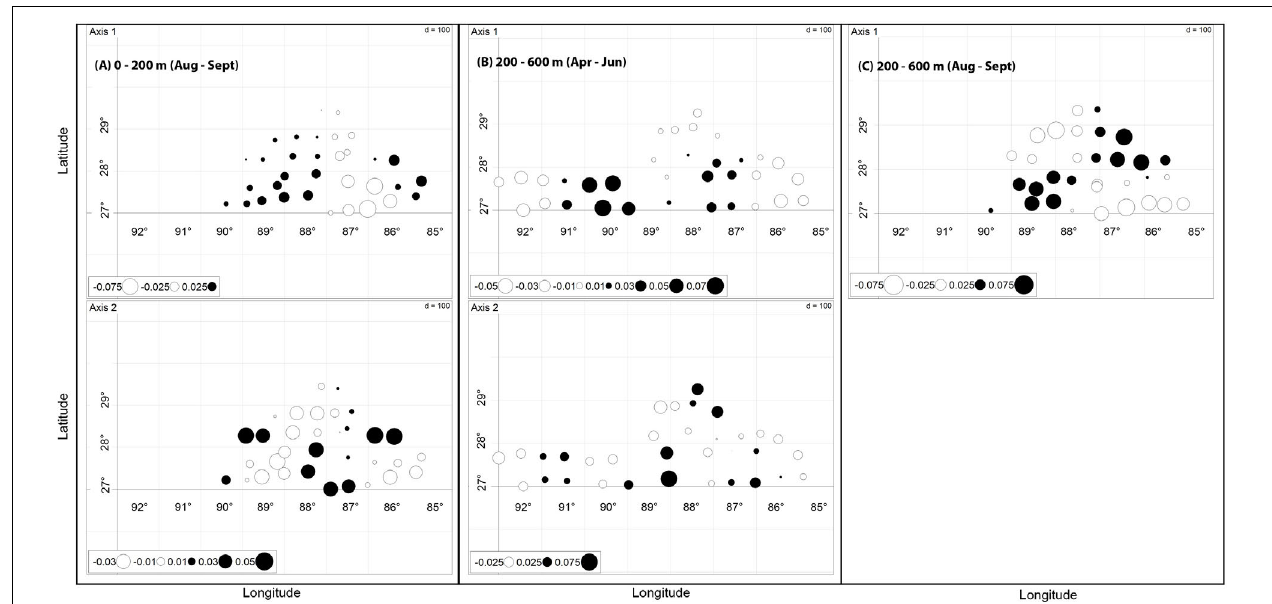
FIGURE 4 | dbMEMs showing significant correlation to myctophid assemblage composition following RDA in (A) 0–200 m (August–September); (B) 200–600 m (April–June); (C) 200–600 m (August–September). In (A,B) two significant axes were identified; in (C) only a single significant axis was identified. Circle color and size represents the values of the eigenvalues that model positive spatial correlation and indicate the scales of spatial patterning in the assemblage data.